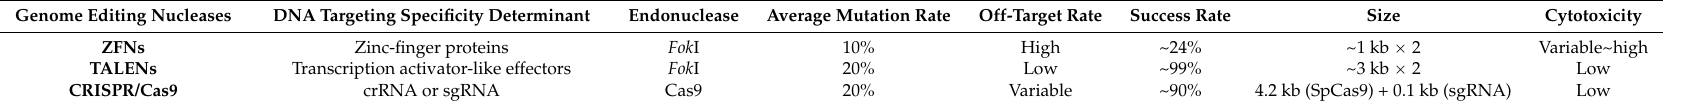
Table 2. Comparison of three programmable nucleases.